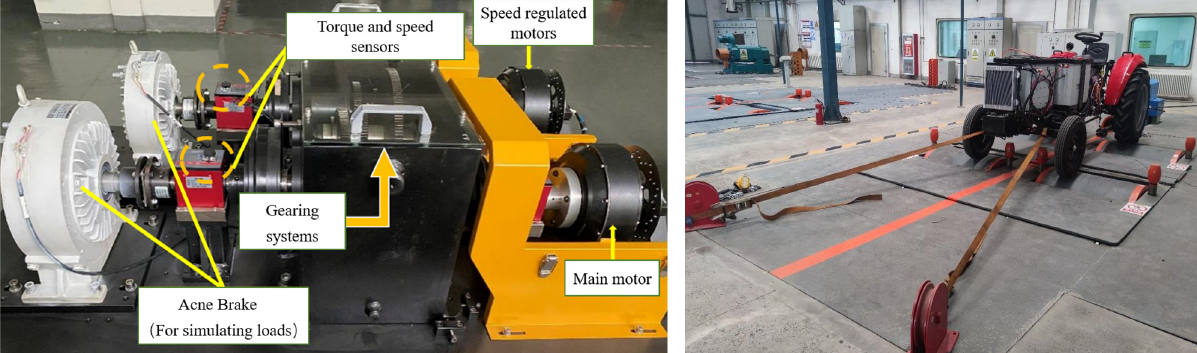
Figure 10. Performance test of motor torque distribution.